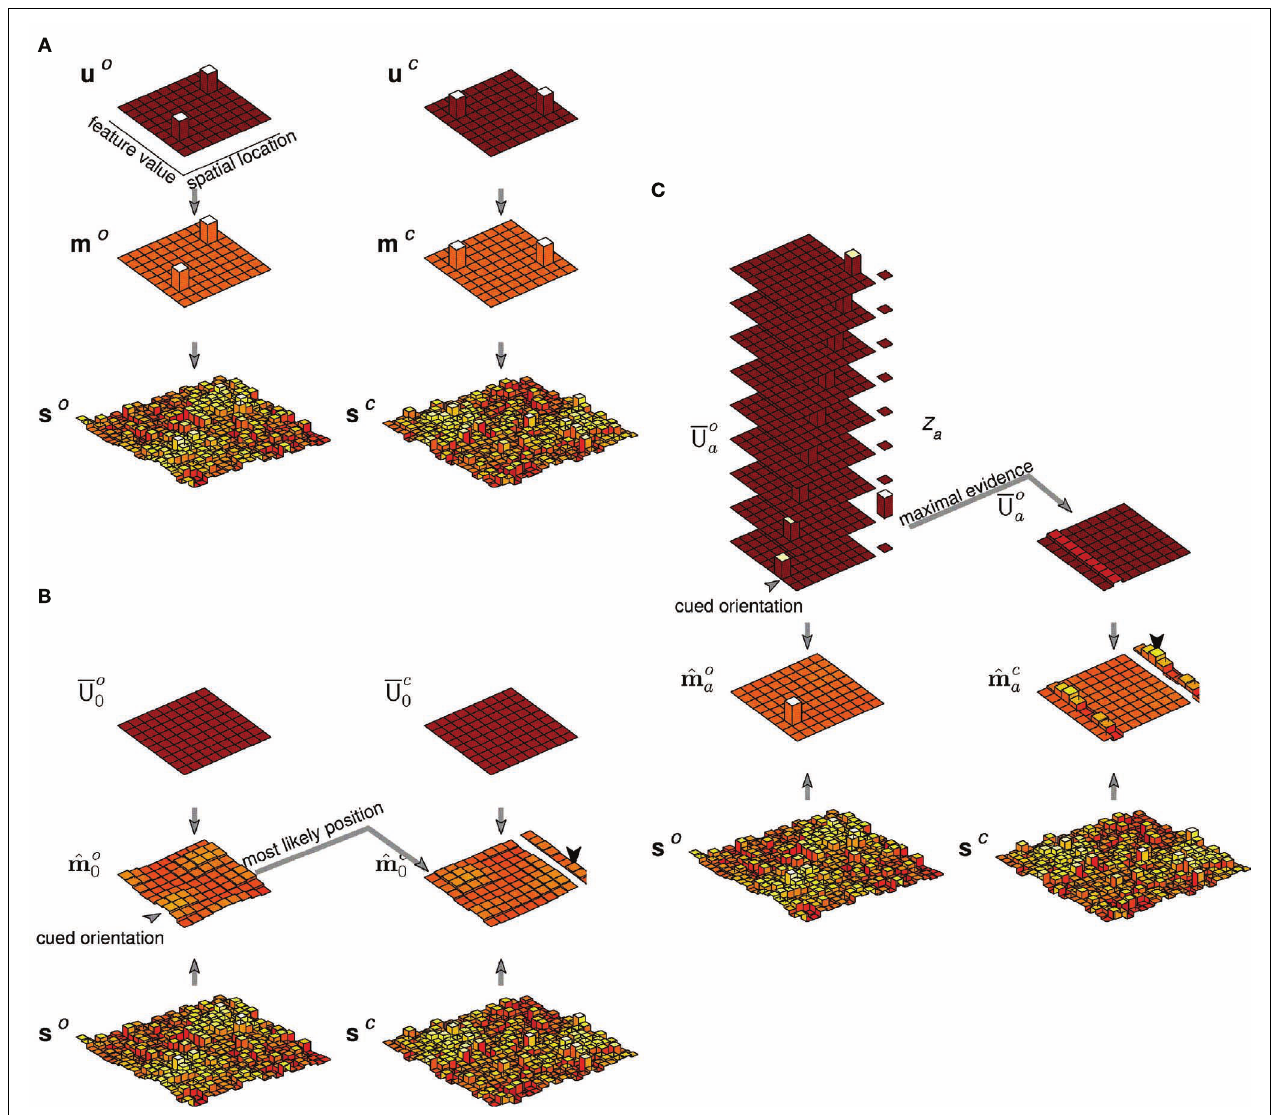
FIGURE 6 | Generation, inference, and decision in a model of binding. (A) Noise in the inferred feature maps leads to an error in the example shown. (C) Generation.Two non-zero entries in each of u o , u c , m o , and m c represent the Inference and decision with attention.The evidence Z a is evaluated for each two oriented, colored bars. Each yields a smeared and noisy bump of activity hypothesis corresponding to an object at different positions with the cued in the sensory cue maps s o and s c . (B) Inference and decision without orientation, depicted by the stack of possible priors.The mean posterior maps (cid:21) m o attention.The mean posterior maps (cid:21) m o and (cid:21) m o are obtained from the and (cid:21) m c are obtained under the attentional hypothesis with greatest a 0 a a generated sensory cue maps s o and s c under non-specific priors (shown as in evidence.The mean color map (cid:21) m c is then summed over space, and the a Figure 4 by the diagonal elements of U 0 , rearranged into a map).The maximum strength value determines the reported color.This process recovers the correct binding with exactly the same instantiation of sensory maximum strength value in (cid:21) m o at the cued orientation selects a location.The 0 activity as in (B) maximum strength value in (cid:21) m c at this location determines the reported color. 0